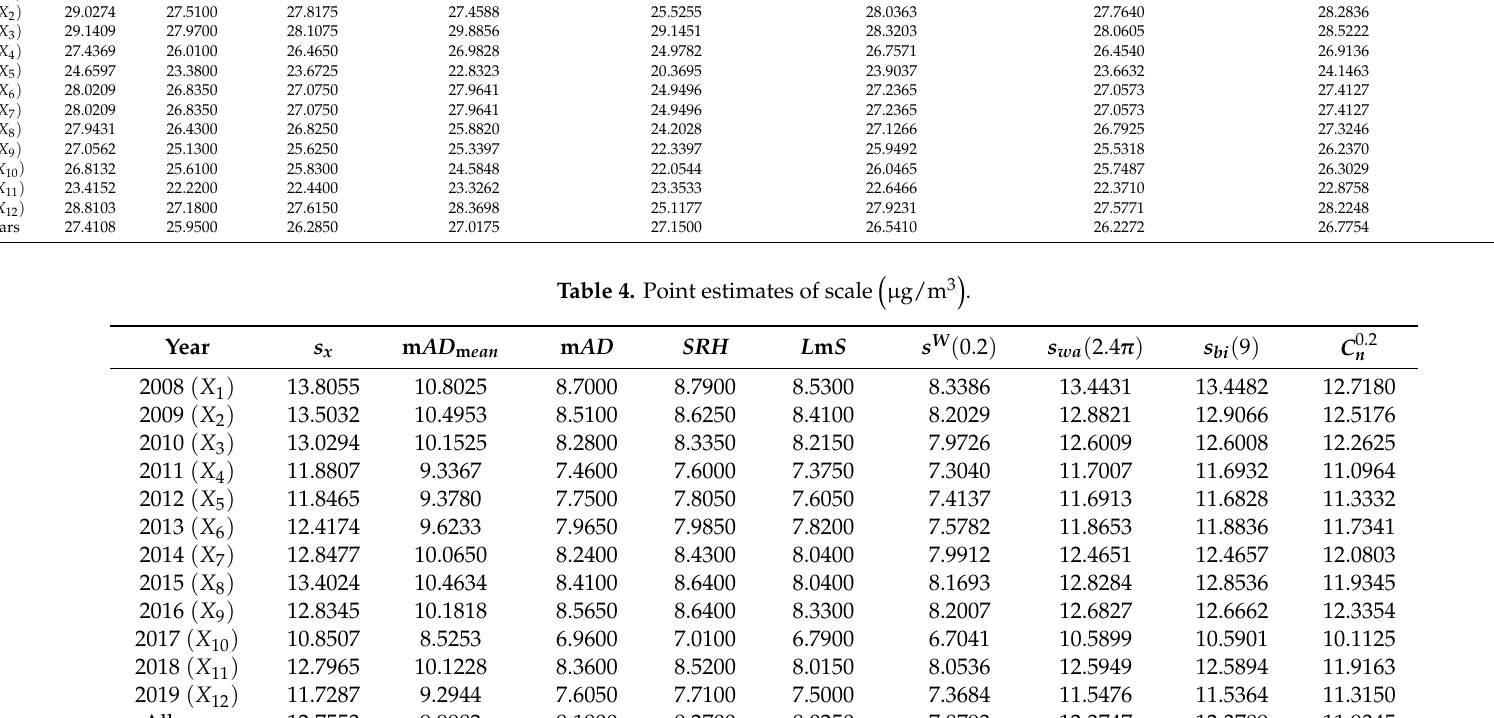
Table 3. Point estimates of location